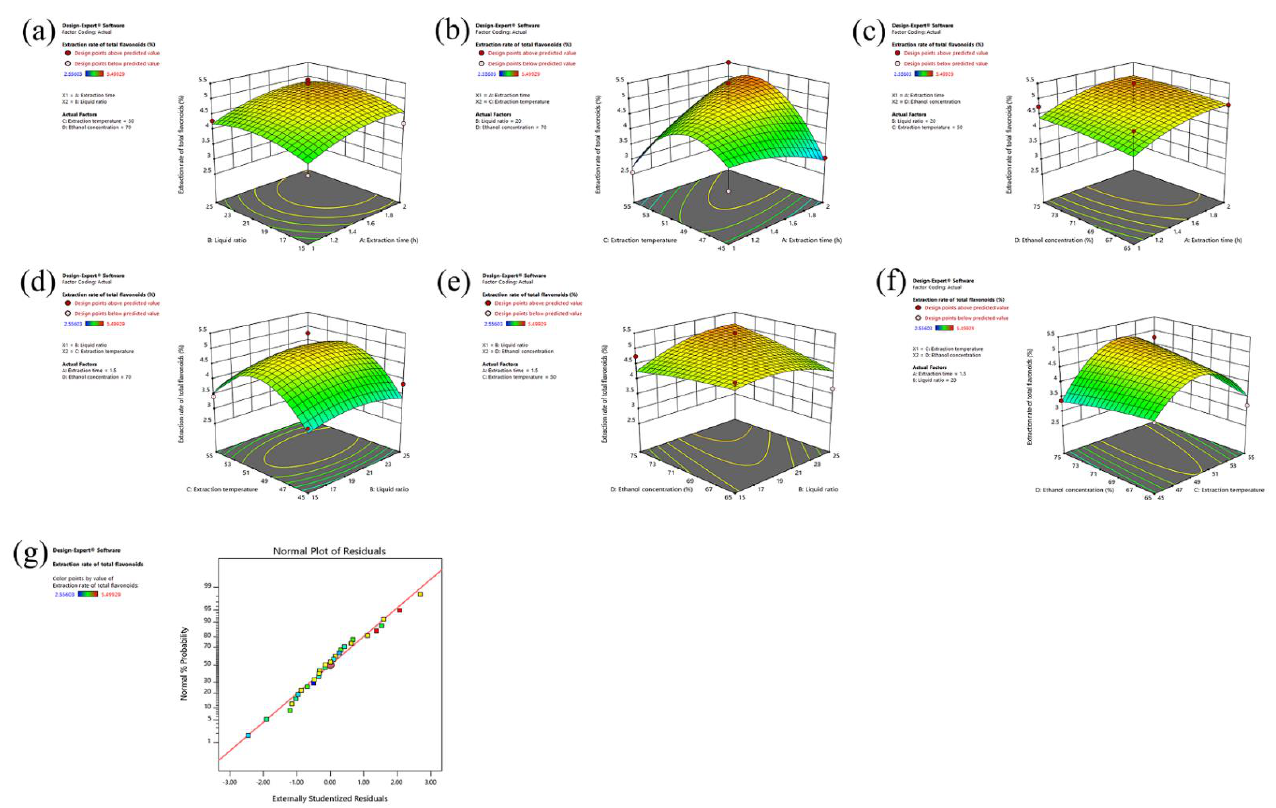
Figure 2. Response Surface Methodology Interaction of Four Factors Affecting the Extraction Rate of Flavonoids from Cotton Flowers. ( a ): The effect of the interaction between liquid-solid ratio and extraction time on the yield of flavonoids. ( b ): The effect of the interaction of extraction temperature and time on the yield of flavonoids. ( c ): The effect of the interaction between ethanol concentration and extraction time on the yield of flavonoids. ( d ): The effect of the interaction between ethanol concentration and liquid-solid ratio on the yield of flavonoids. ( e ): The effect of the interaction between ethanol concentration and extraction temperature on the yield of flavonoids. ( f ): The effect of the interaction between ethanol concentration and extraction temperature on the yield of flavonoids. ( g ): Normal distribution.